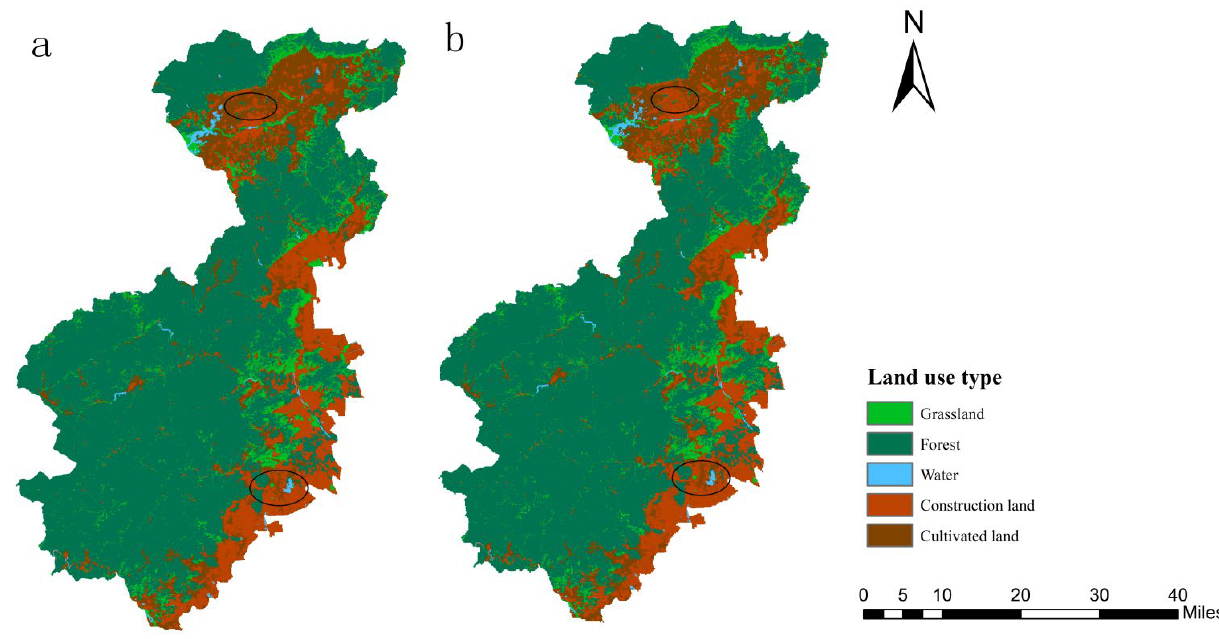
Figure 7. Land-use simulation maps under the: ( a ) natural development scenario, and ( b ) regional planning policy impact scenario in the ECA of western Beijing in 2030. The black circles in this figure are different places between the two